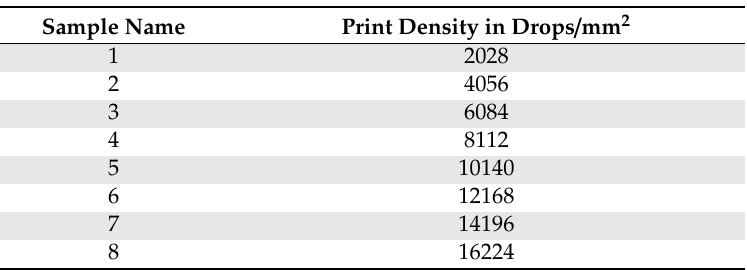
Table 2. A colorimetric paper strip for H 2 S detection with di ff erent print densities in dops / mm 2 of copper acetate films on a paper substrate.